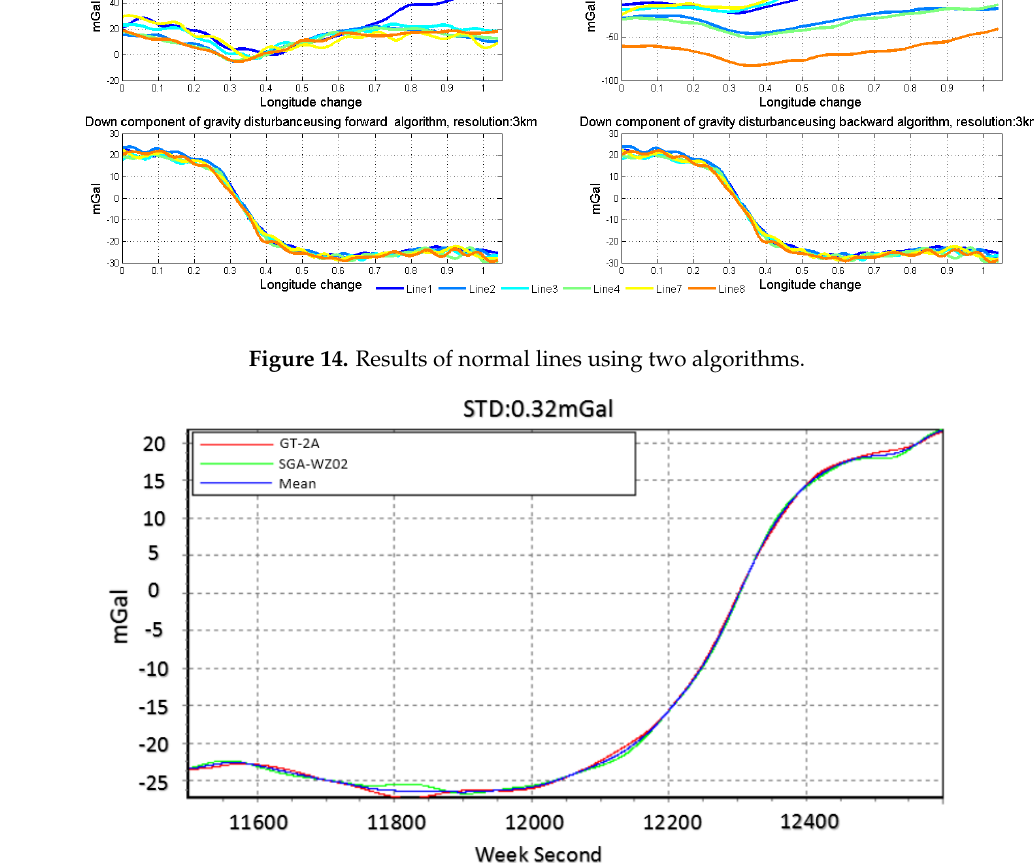
Figure 15. Mean value of vertical component among normal lines in GT-2A and